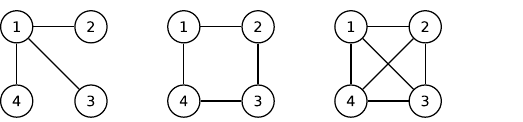
Figure 3. Three candidate graphical models: a star graph S 3 , a cycle graph C 4 , and a complete graph K 4